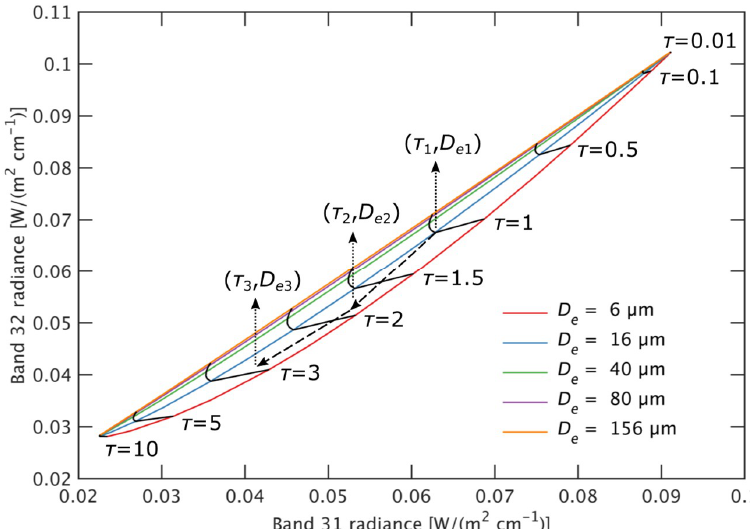
Figure 9. Infrared retrieval lookup table generated by using radiances from MODIS bands 31 and 32 and applying the two-habit ice cloud model (see Figure 11). Black lines indicate different visible optical thickness from 0.01 to 10. Red, blue green, purple, and yellow lines indicate different effective diameter from 6 to 156 μm. Arrowed dashed lines show retrieval iteration processes.